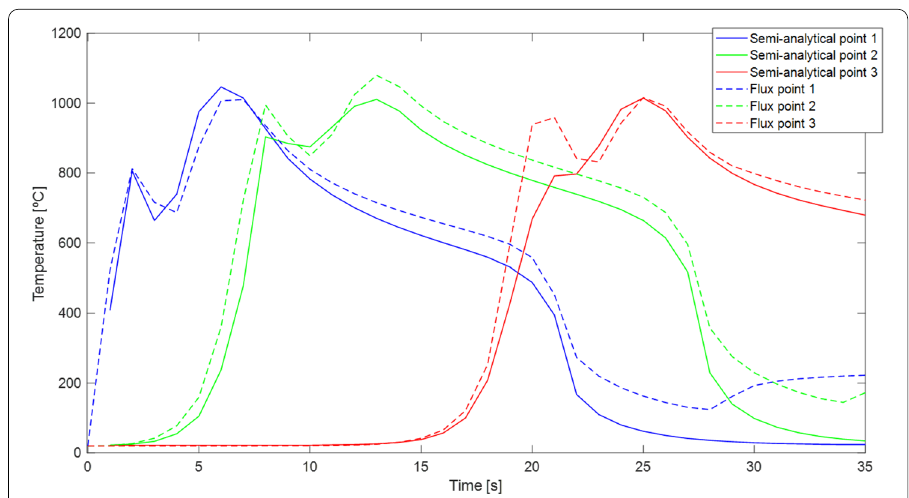
Fig. 14 Comparison of temperature evolution at different points as computed by the semi-analytical model and the commercial software